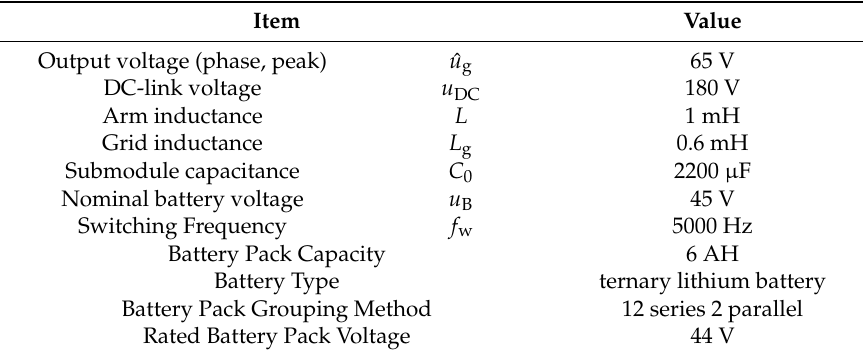
Table 3. The parameters of the experimental system.